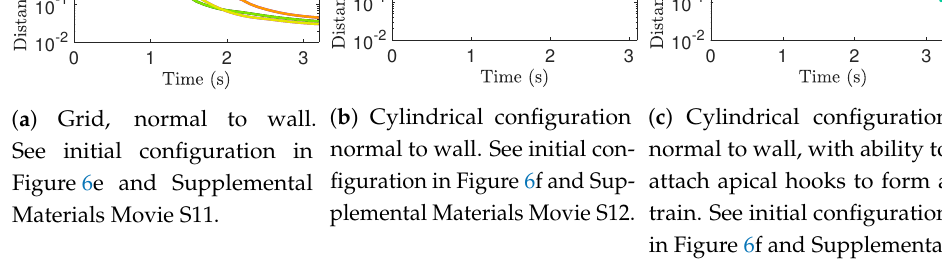
Materials Movie S11.